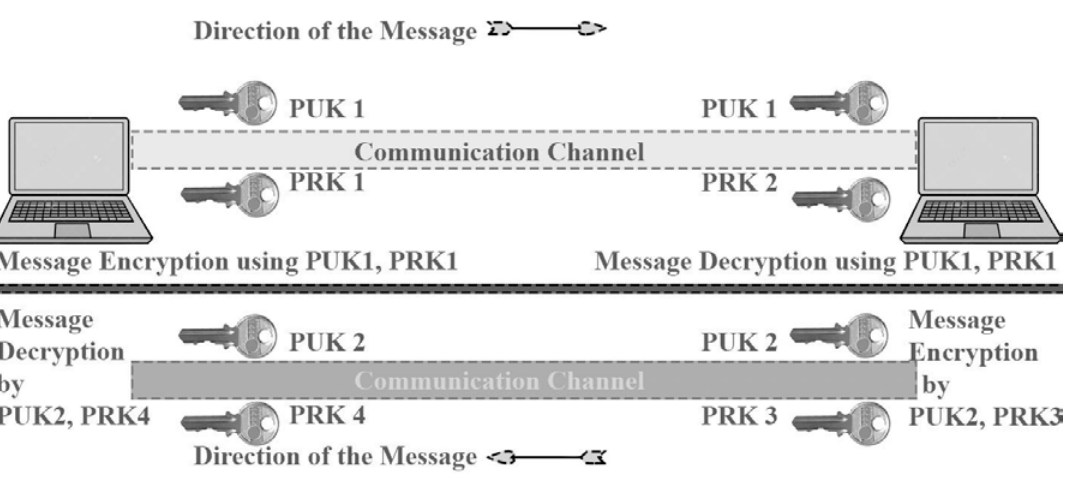
Figure 2. Double RSA algorithm & how it works